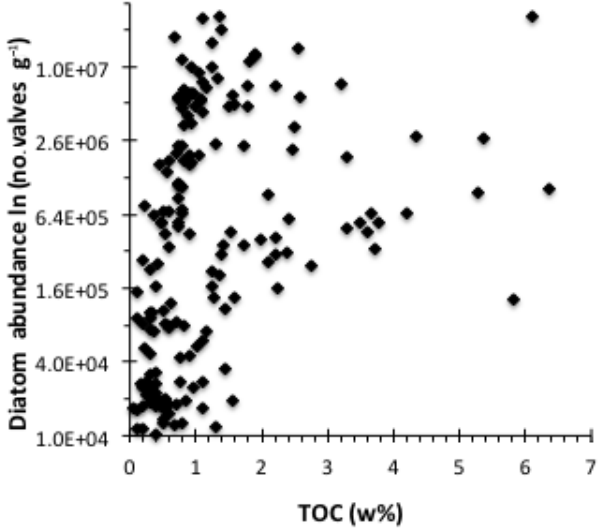
Figure 2. Relationship between total marine diatom abundance ln (no. of valvesg − 1 ) and total organic carbon content wt%) for the Canary (Galicia to the Canaries), Humboldt (southeastern Pacific), and California (northeastern Pacific) systems.